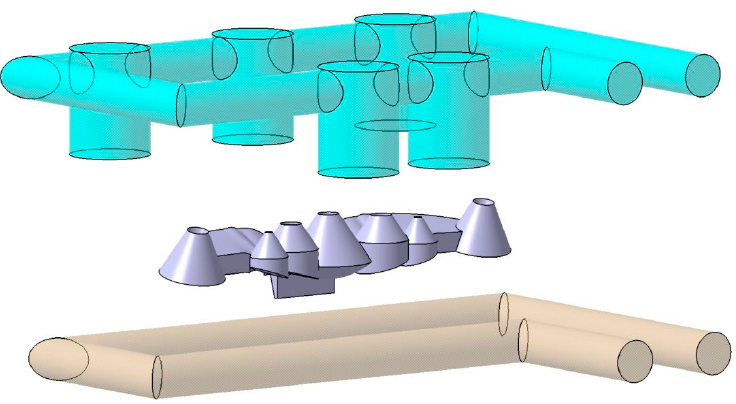
Figure 3. Traditional cooling solution for the collimating optical part.